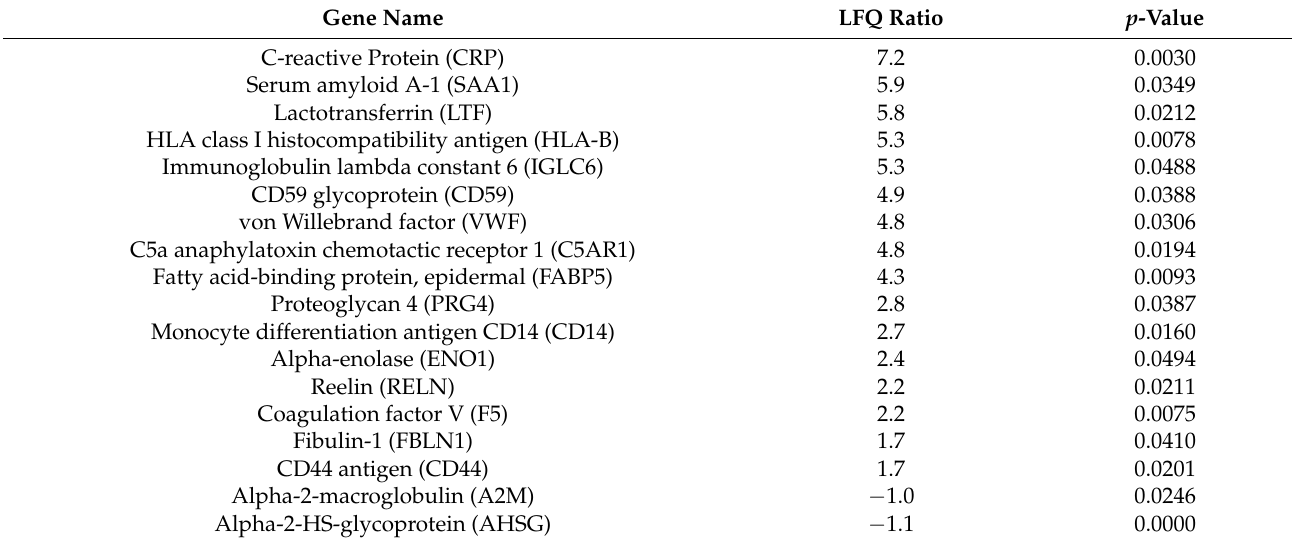
Table 2. Differentially expressed proteins in plasma EVs from human burn patients during the first 72 h of injury by LC-MS/MS. n = 3 burn-injured patients, 3 healthy controls. Key: LFQ-Label-free